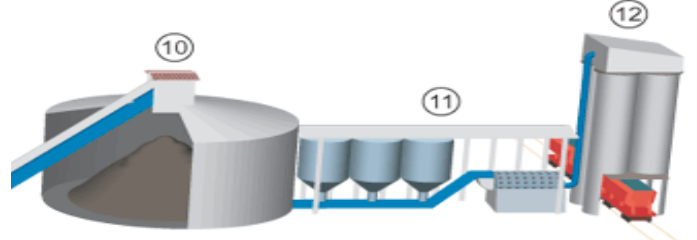
Figure 5. The third phase completion of cement production. Source: own source.